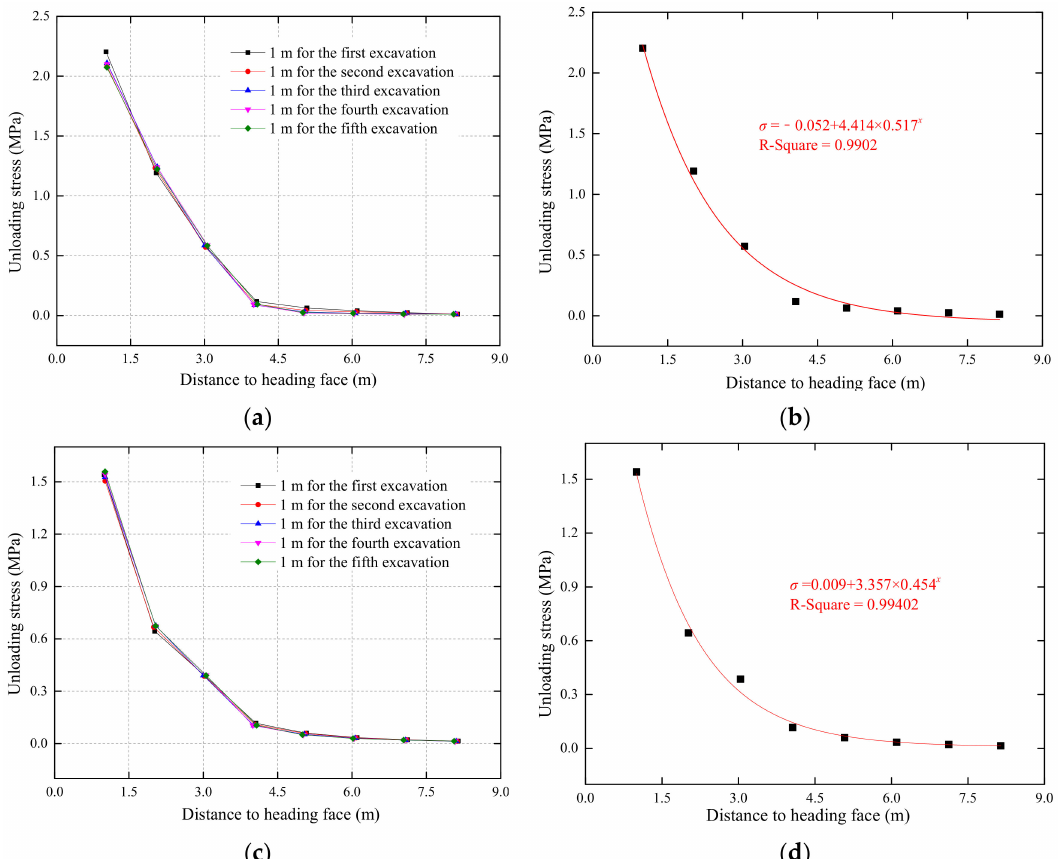
Figure 9. Stress distribution laws of unloading disturbance of head-on driving: ( a ) stress distribution curve of unloading disturbance of head-on driving in deep-buried high-stress roadway; ( b ) fitting function and curve of unloading disturbance stress of head-on driving in deep-buried high-stress roadway; ( c ) stress distribution curve of unloading disturbance of head-on driving in shallow buried low-stress roadway; ( d ) fitting function and curve of unloading disturbance stress of head-on driving in shallow buried low-stress